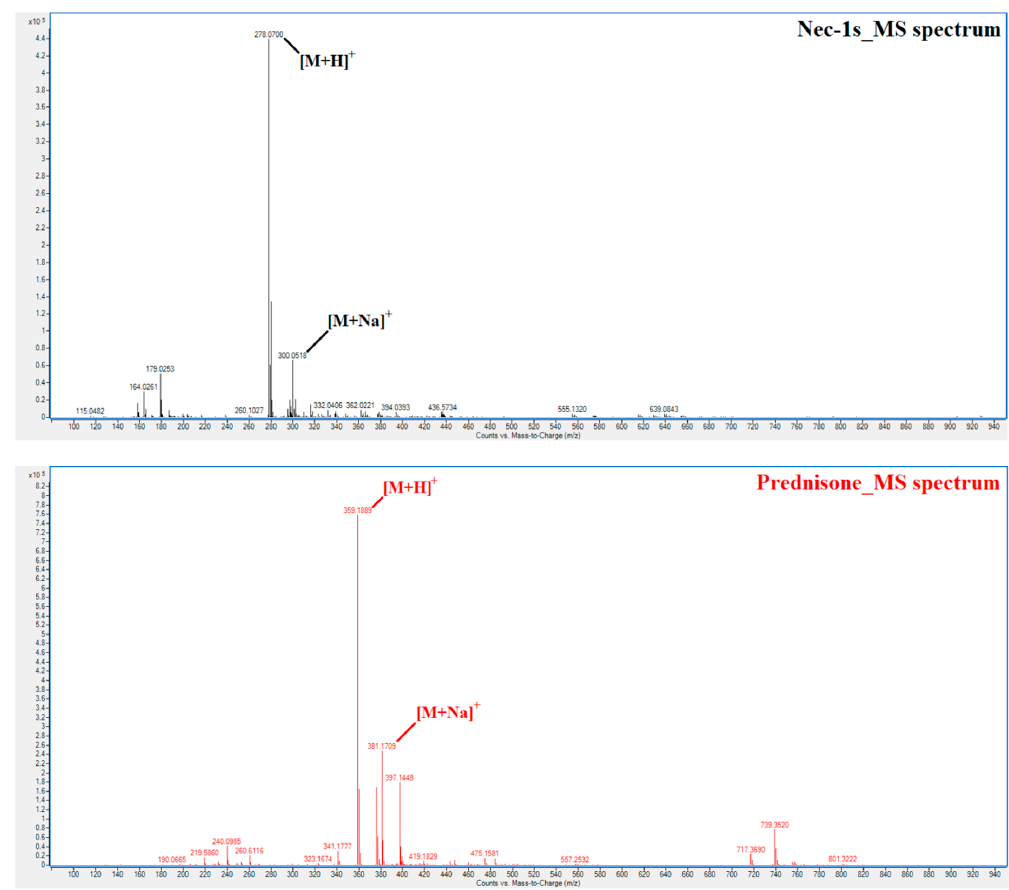
Figure 4. MS spectra of Nec-1s and prednisone. FIA analysis of Nec-1s ( upper panel ) and prednisone ( lower panel ) stock solutions showing experimental masses for their H + and Na + adducts.